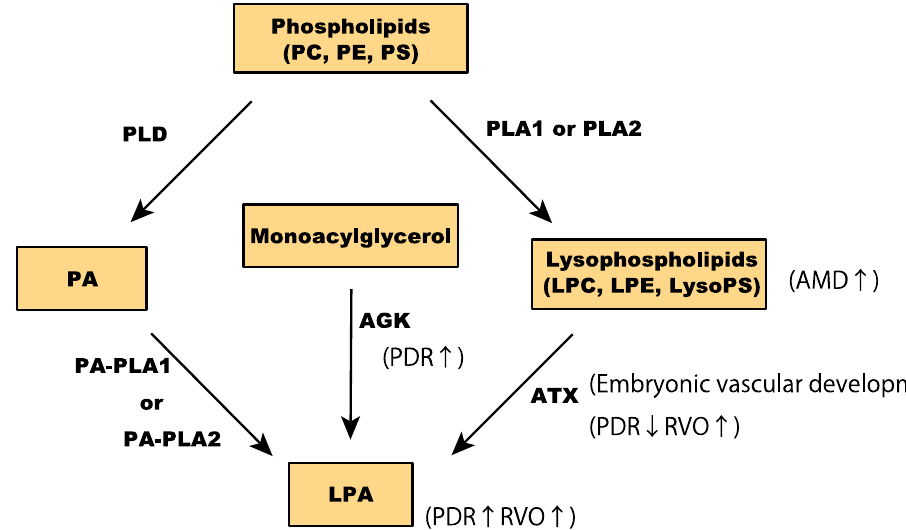
Figure 3. Conversion of glycerophospholipids to LPA (lysophosphatidic